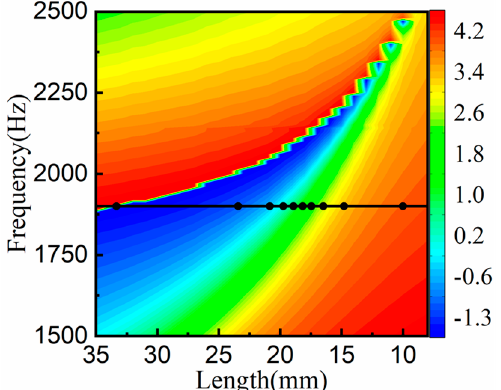
Figure 4. The reflection phase manipulation map of SHCs with different lengths, where the corresponding frequency of the black curve is the designed center frequency and the corresponding length of the black circle symbols is selected as the length of ten SHCs.